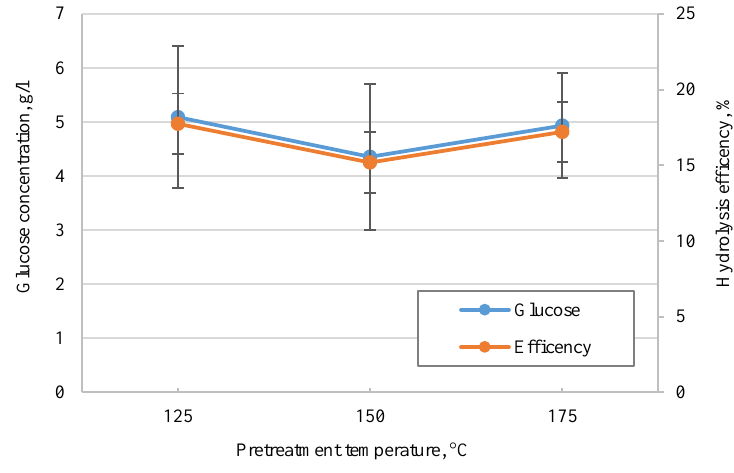
Fig. 2. Hydrolysis efficiency and glucose concentration in hydrolysis mixture in case of different pretreatment